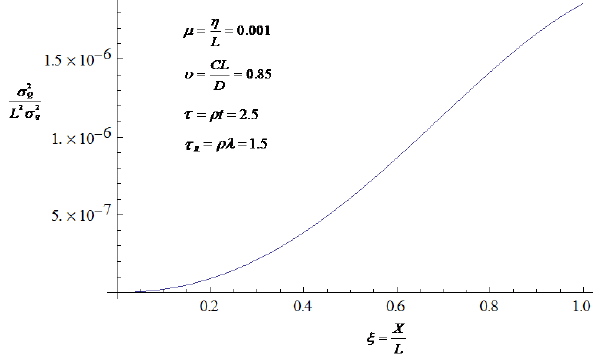
Figure 3. Dimensionless variance of discharge fluctuations as a function of dimensionless distance from the upstream